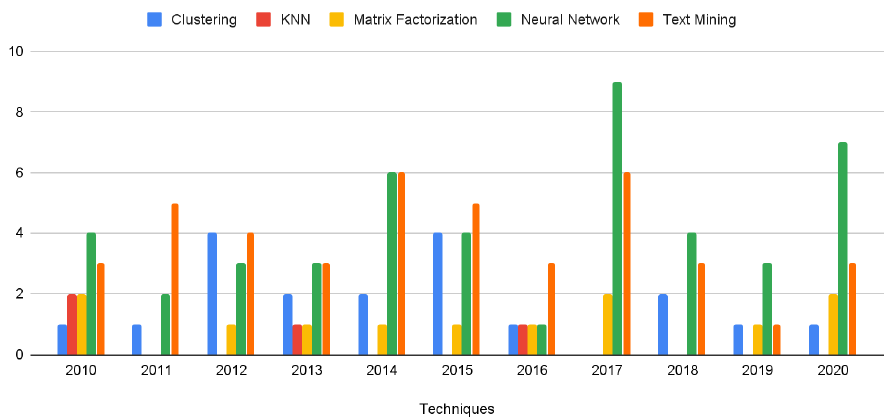
Figure 15. Trend in recommendation technique papers by year (by period) during the period investigated in this paper (2010–2020).